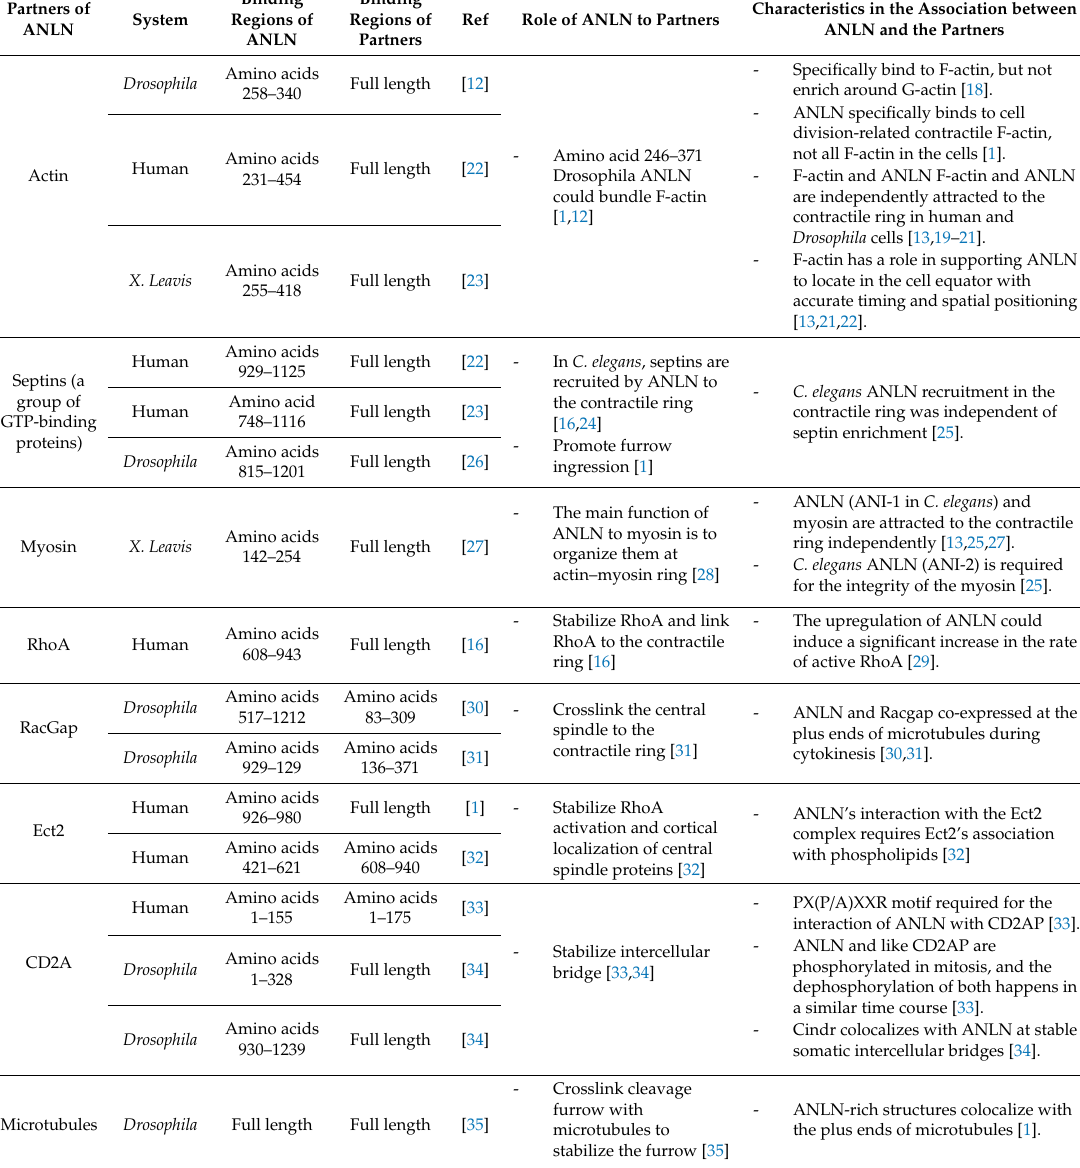
Table 1. The roles and characteristics of ANLN and its partners in